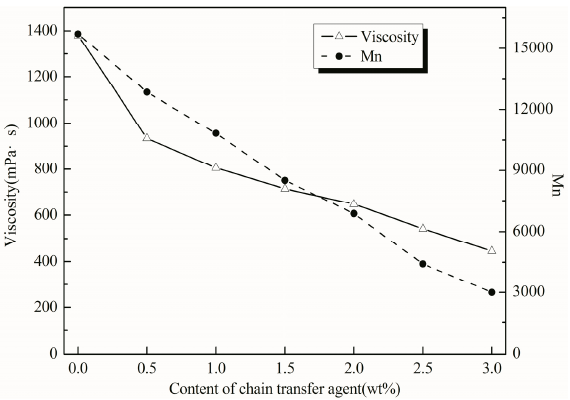
Figure 6. Effect of the content of chain transfer agent on viscosity and molecular weight. Conditions: The ratio of PET/AC was 1/5, and AA/MAA/BA/St/HEMA/BMA was 1.2/2.6/5.2/15.3/35/40.7 in this series reaction.